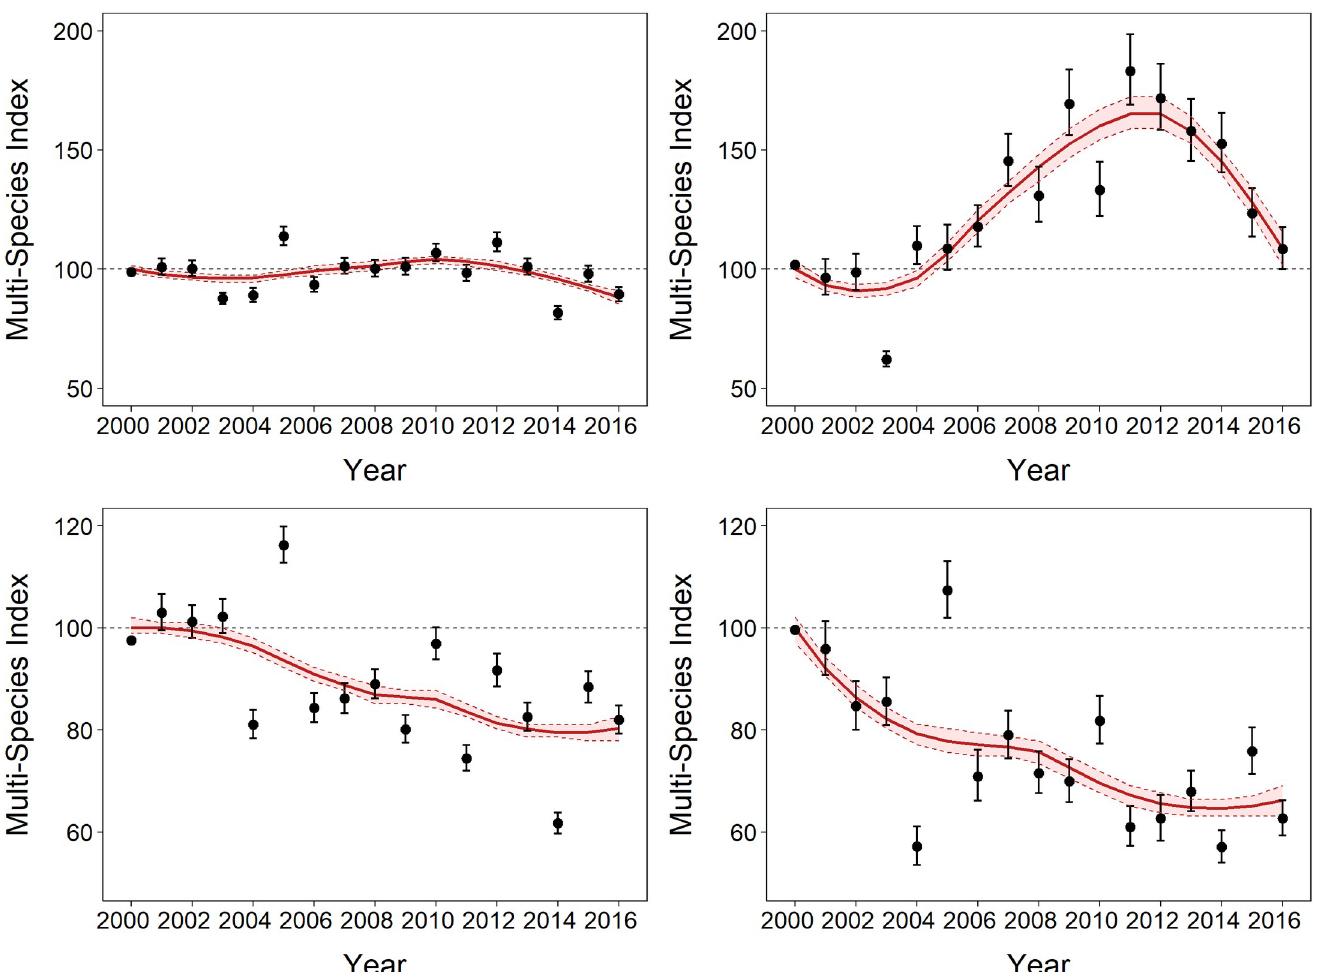
Fig 1. Trends in local abundance from 2000 to 2016 based on the multi-species indicators for a) all species, b) habitat generalists, c) regional endemic species and d) rainforest specialists. Values are the multi-species index with SE (error bars) with the smoothed trend line with 95% CI (shaded area).